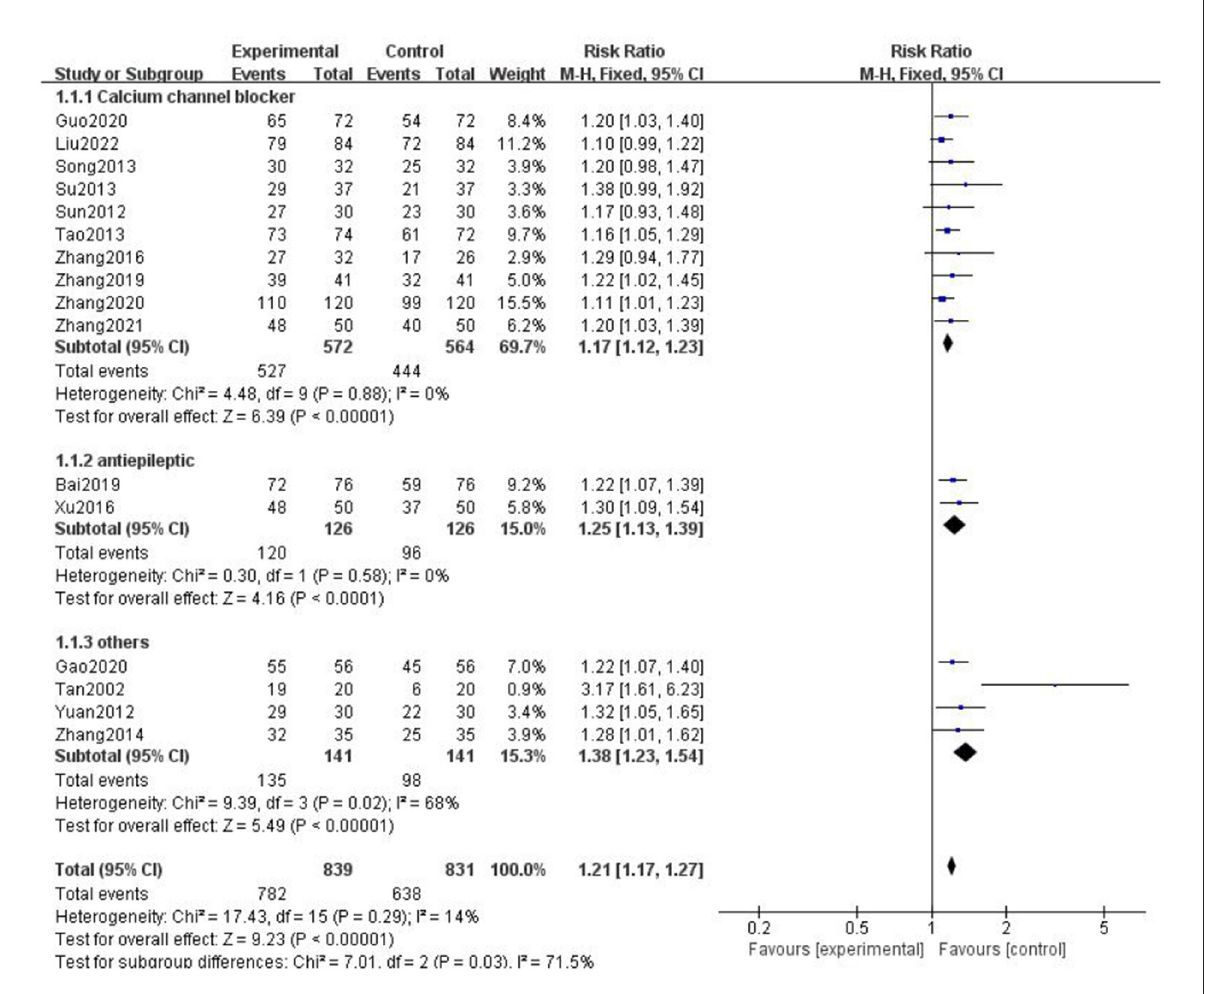
FIGURE4 Forest chart of clinical trial efficacy divided into subgroups according to interventions.